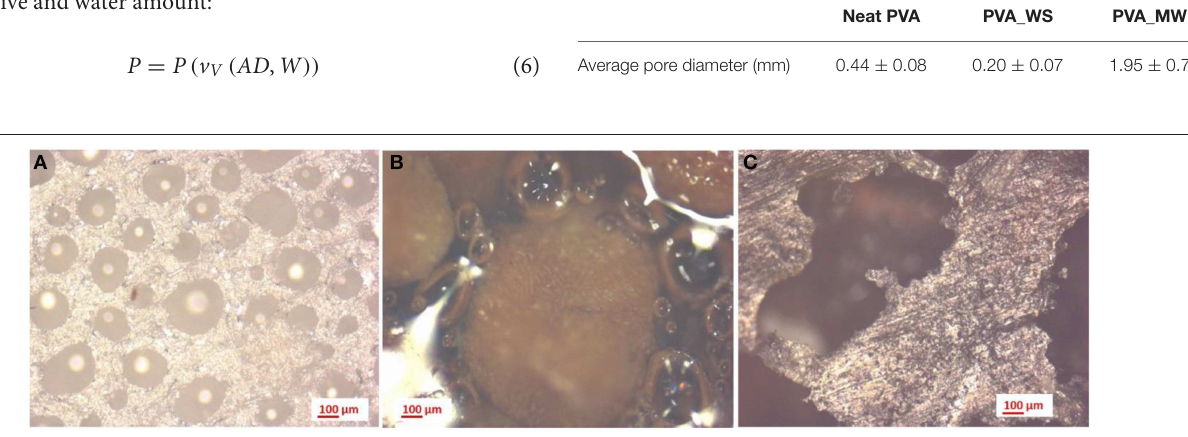
FIGURE 11 | 50x magnification on PVA samples: (A) without additives, (B) with walnut shells, and (C) with mixed waste.